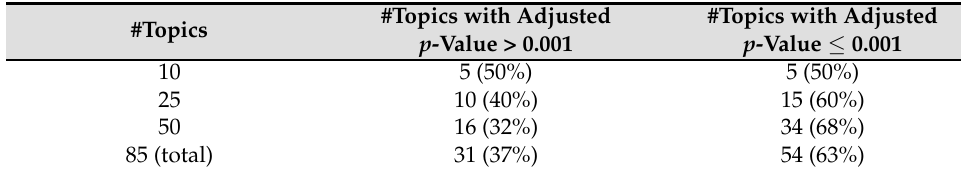
Table 6. GUs vs. NGUs based on three sets of